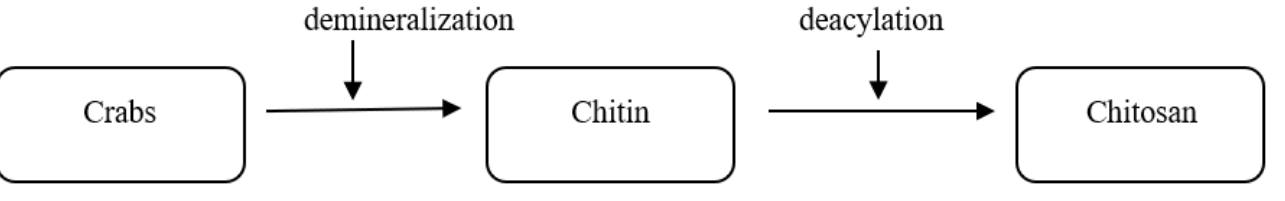
Figure 1. Preparation of